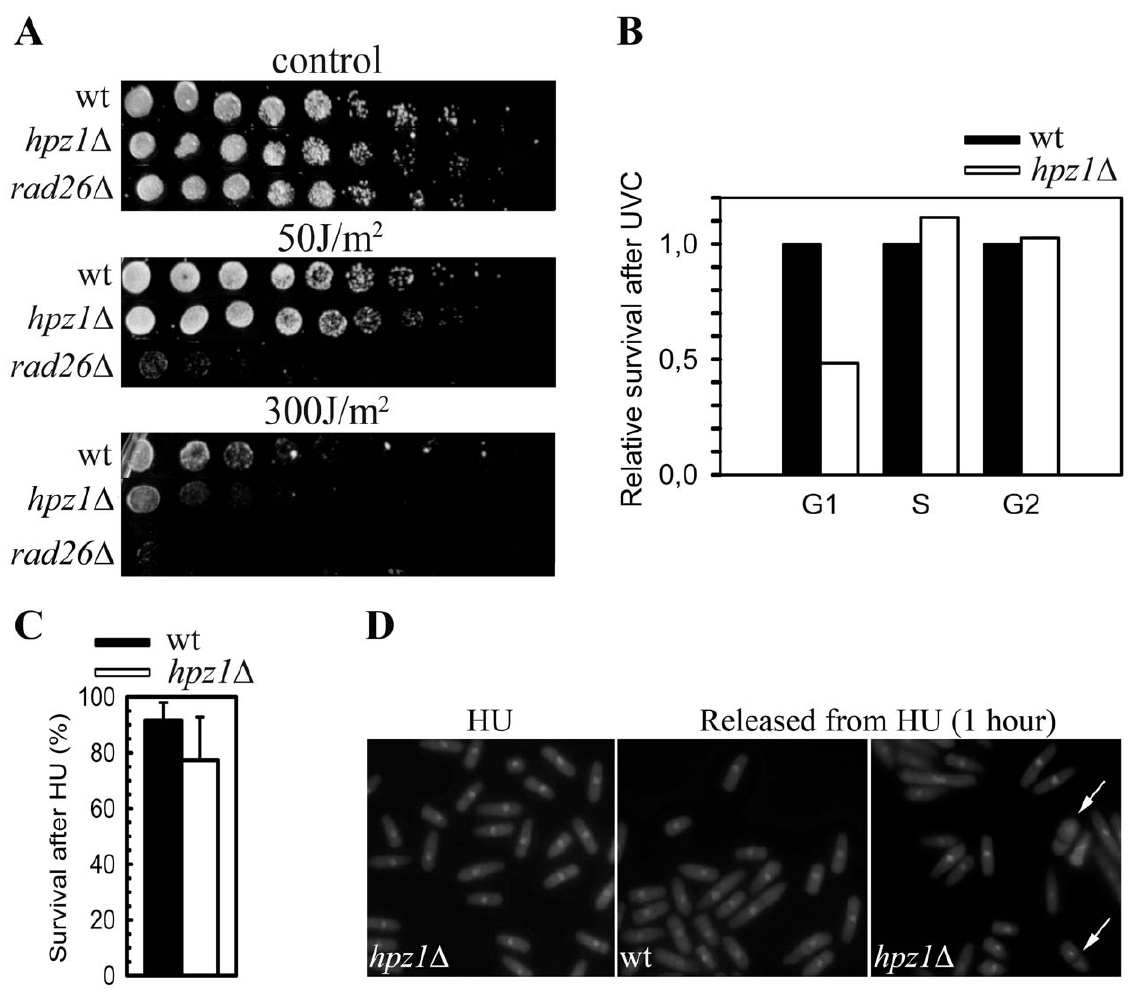
Figure 2. UVC- and HU-sensitivity. A. Spot test for UVC sensitivity of wild-type (wt), hpz1 D and rad26 D cells. Upper: unirradiated cells, center: 50J/ m 2 , lower: 300J/m 2 . B: Survival after UVC irradiation of wild-type or hpz1 D cells in G1, S or G2 phase. The survival of wild-type cells was normalized to 1 in each cell cycle phase (data without normalization are shown in Fig. S1). C. Survival of wild-type or hpz1 D cells after HU-treatment. D. Microscopy images of hpz1 D cells in HU (left) and 1 hour after release from HU (center) and wild-type cells released from HU (right). The DNA was stained with 4 9 ,6-diamidino-2-phenylindole ( DAPI). The arrows point to cut cells.